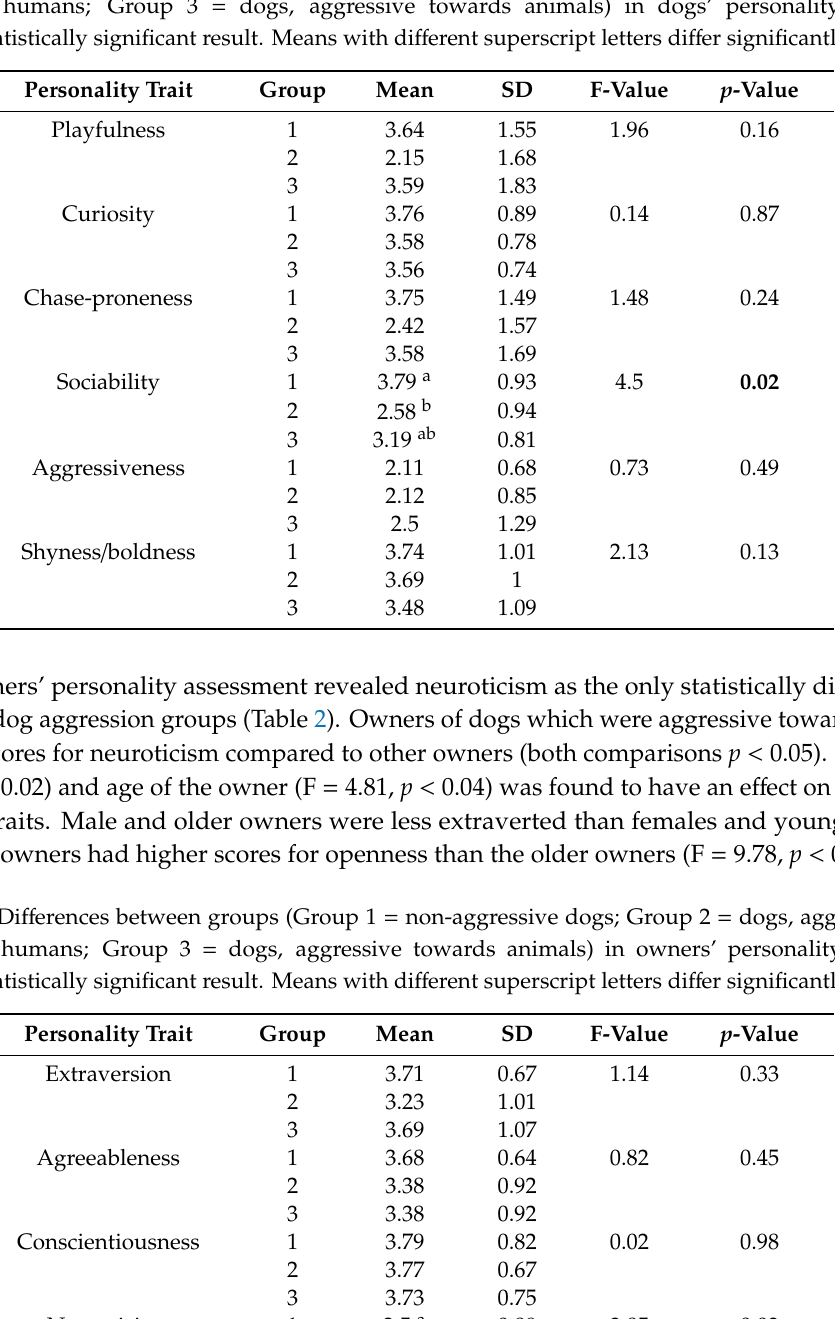
Table 1. Di ff erences between groups (Group 1 = non-aggressive dogs; Group 2 = dogs, aggressive towards humans; Group 3 = dogs, aggressive towards animals) in dogs’ personality traits.